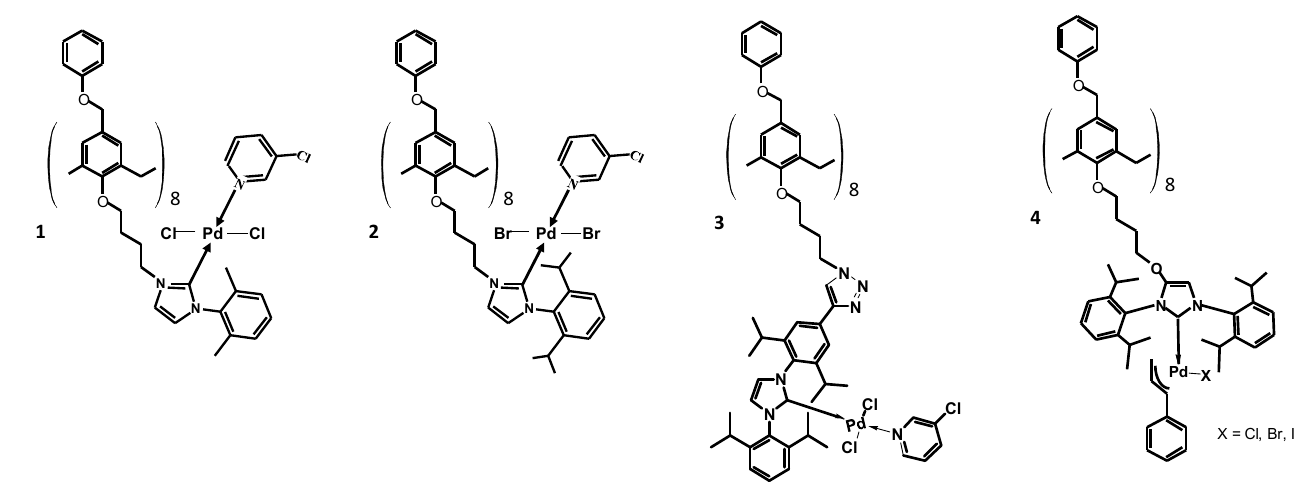
Figure 1. Previously described calix[8]arene-based catalysts.